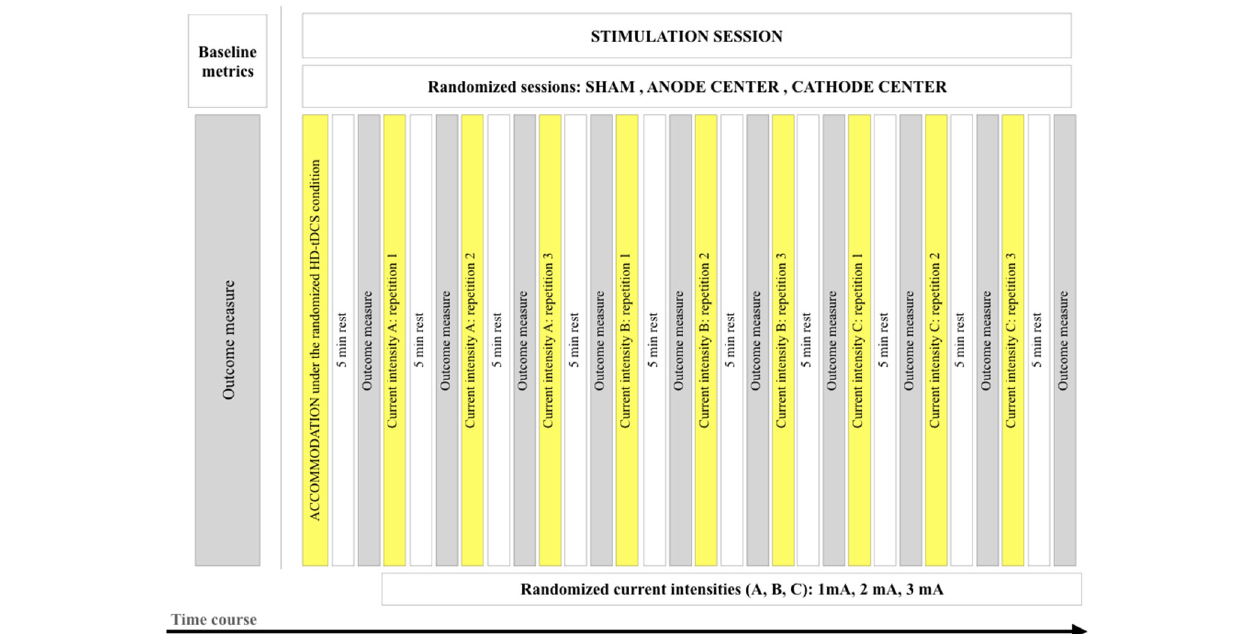
Frontiers in Neurology |